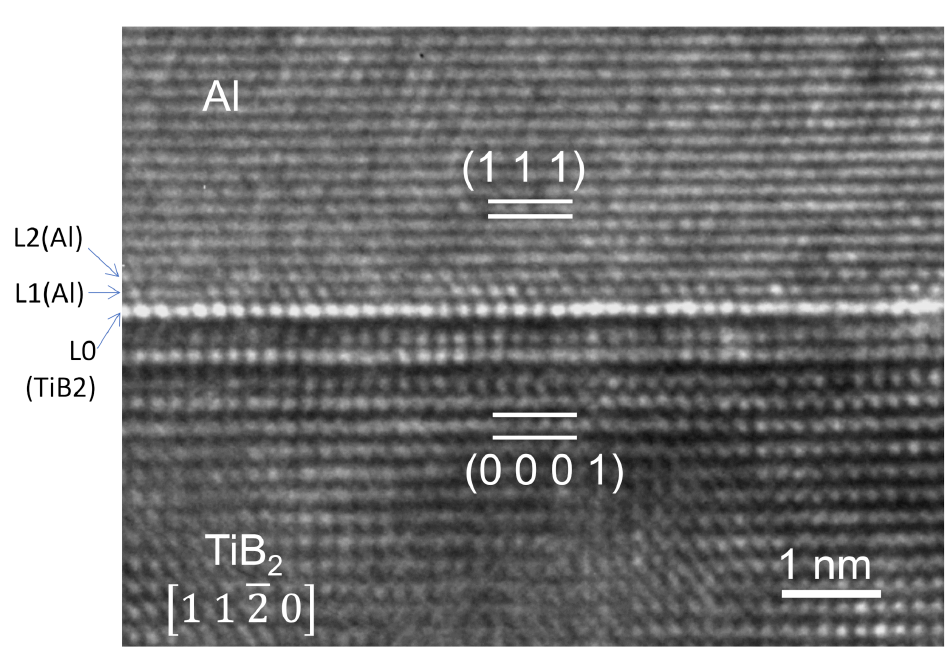
Figure 10. Experimental validation of lattice twist in systems with negative misfit [67] (Copyright 2017 The Minerals, Metals & Materials Society. Used with permission) . High resolution TEM micrograph showing that on the (0001) TiB 2 substrate there exists an epitaxial first layer (L1(Al)) and a twist of the solid Al relative to the TiB 2 substrate. {111} Al has a is misfit of − 4.2% with the (0001) TiB 2 substrate. The tilting experiment during TEM examination has confirmed a 4.7 ◦ twist of Al relative to the TiB 2